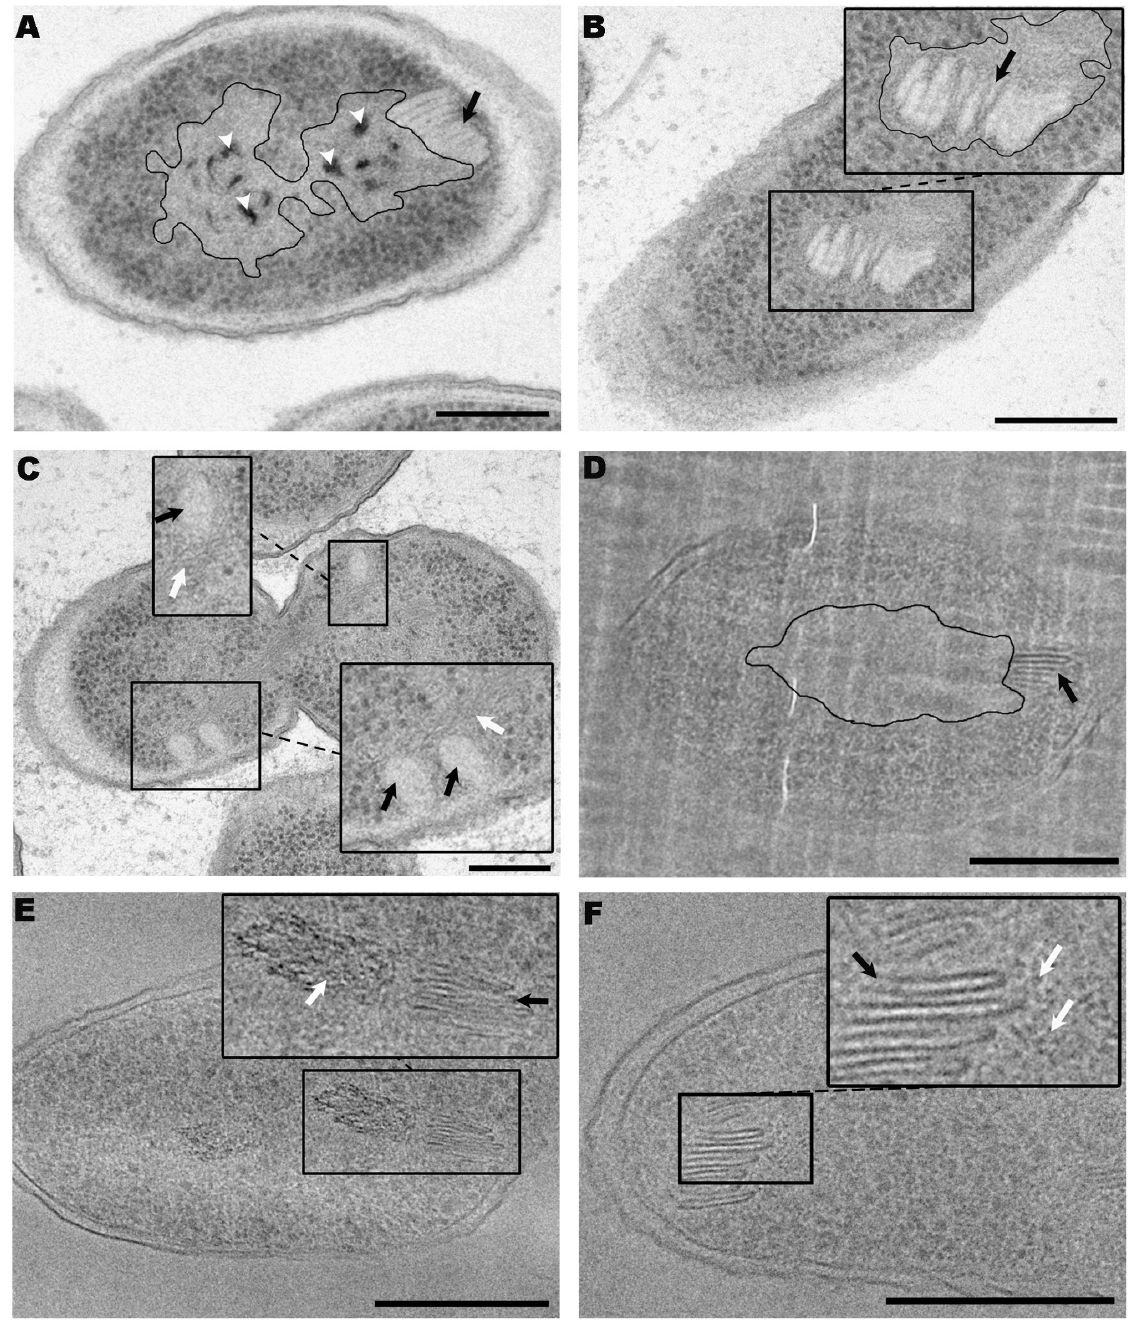
Figure 5. Study of the proximity between stacks and DNA observed in TSA-grown cultures of P. deceptionensis M1 T cells. (A–C) TEM micrographs of 60 nm Epon sections of samples processed by HPF-FS. (A) A stack (black arrow) perpendicular to the PM and very close to the bacterial nucleoid (outlined area). The bacterial nucleoid shows dark spots, corresponding to poly P granules (white arrow heads). (B) A stack (black arrow) embedded in the nucleoid area (outlined area) is shown. (C) A P. deceptionensis M1 T dividing cell distributing its DNA between its daughter cells is observed, in which stacks (black arrows) are visualized very close to the DNA (white arrows). (D–F) Cryo-TEM micrographs of 50 nm vitreous cryosections (CEMOVIS). (D) A stack (black arrow) is observed very close to a ribosome free area (RFA), corresponding to the nucleoid area (outlined area). (E) A stack (black arrow) is placed in the vicinities of a locally ordered arrangement of DNA microfibers (white arrow). (F) A stack (black arrow) is visualized very close to DNA microfibers (white arrows). Scale bars = 250 nm.